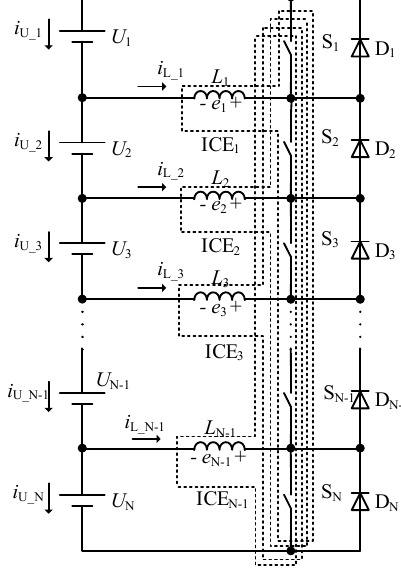
Figure 5. Simplified cell ‐ to ‐ pack topology.